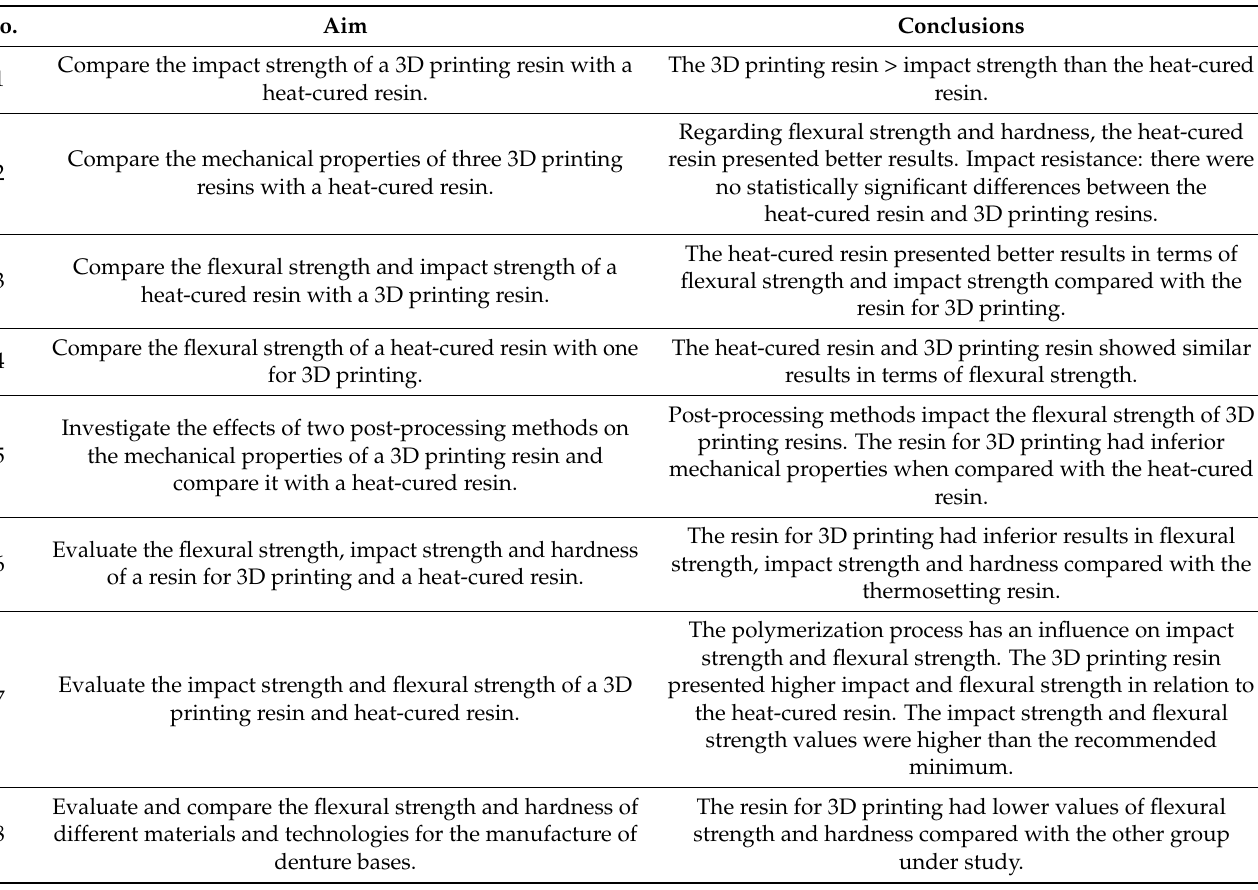
Table 3. Aims and conclusions of the studies